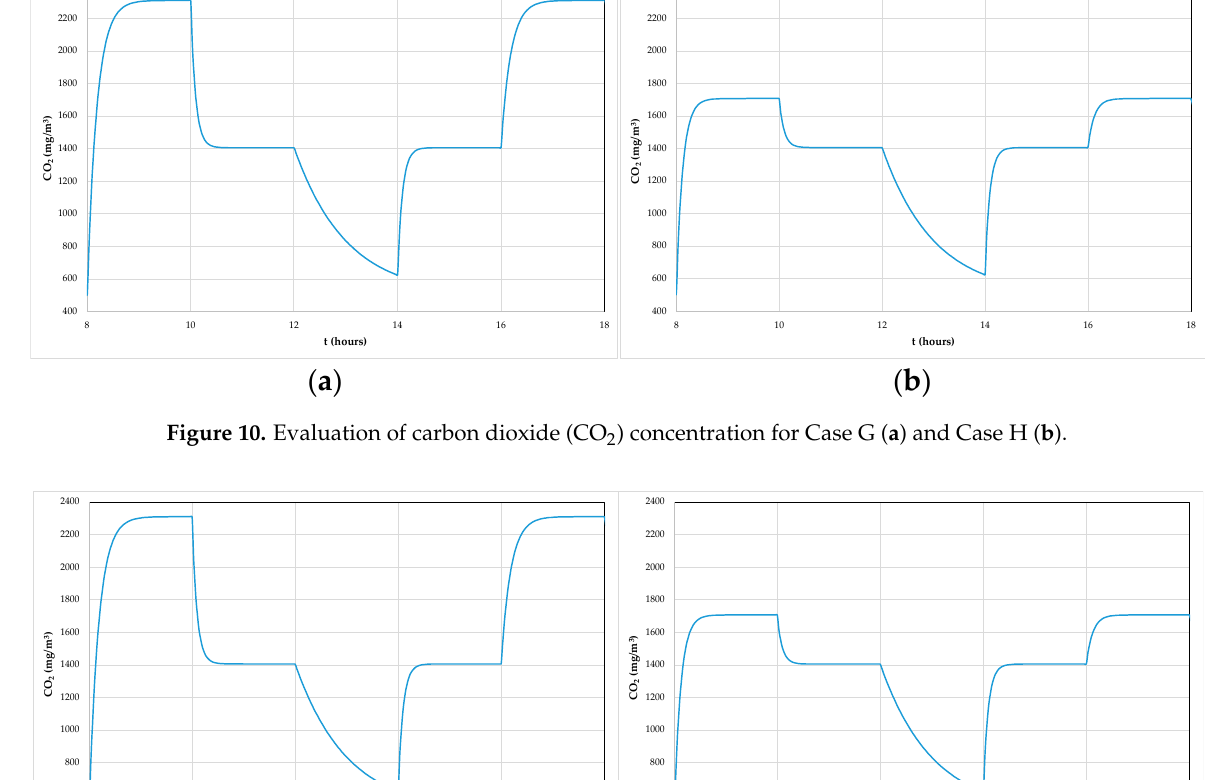
Figure 9. Evaluation of carbon dioxide (CO 2 ) concentration for Case E ( a ) and Case F ( b ).